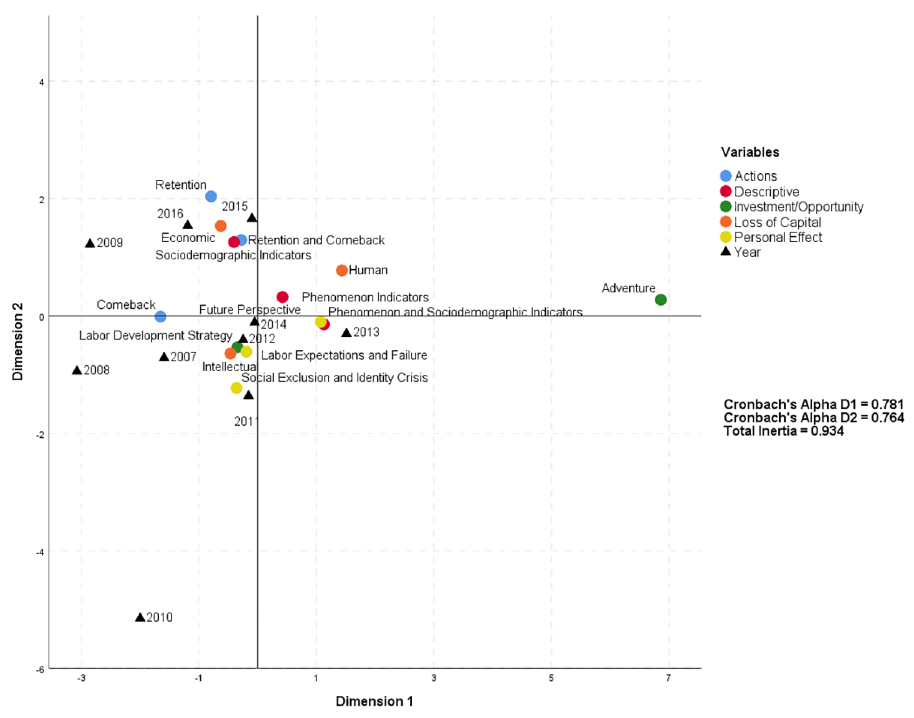
Fig 3. Correspondence analysis of assessment of the phenomenon and